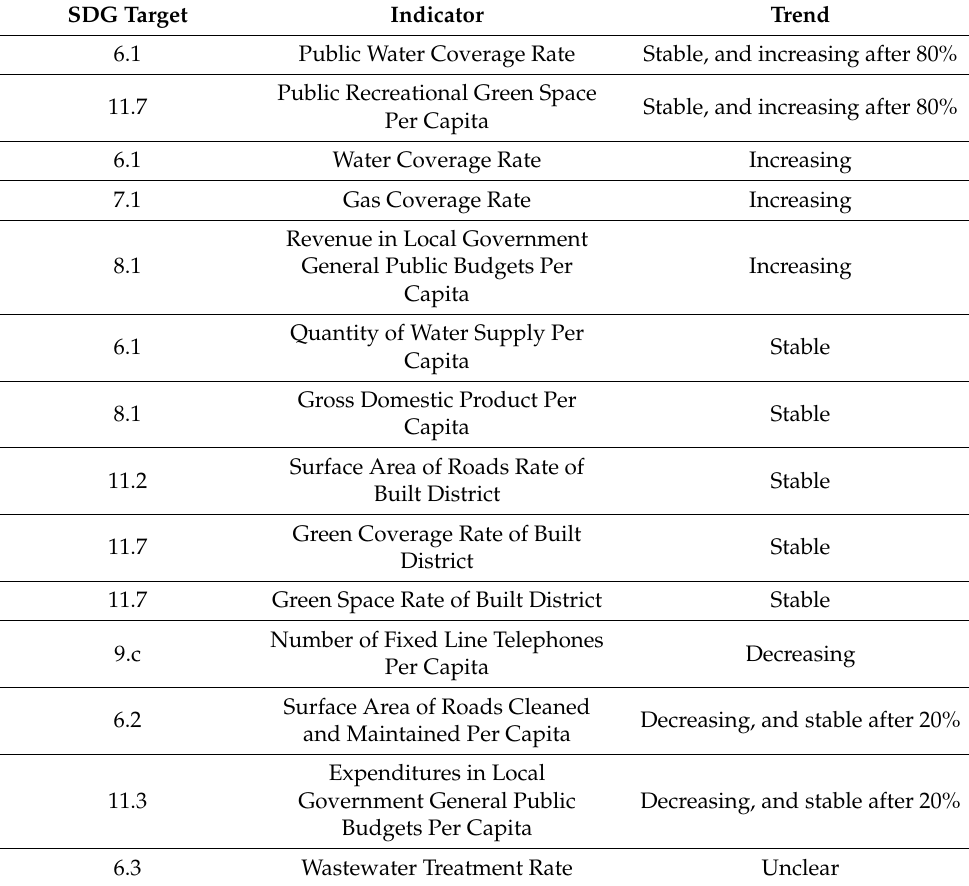
Table 2. The description of the trends of AWD for 14 important indicators along the total